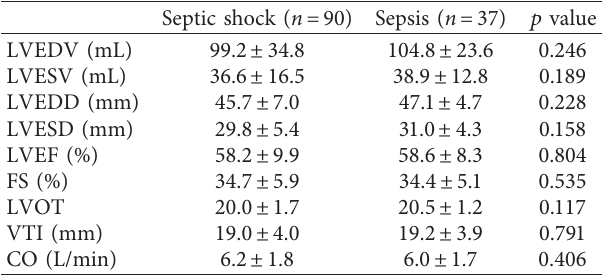
Table 2: Conventional echocardiographic variables.